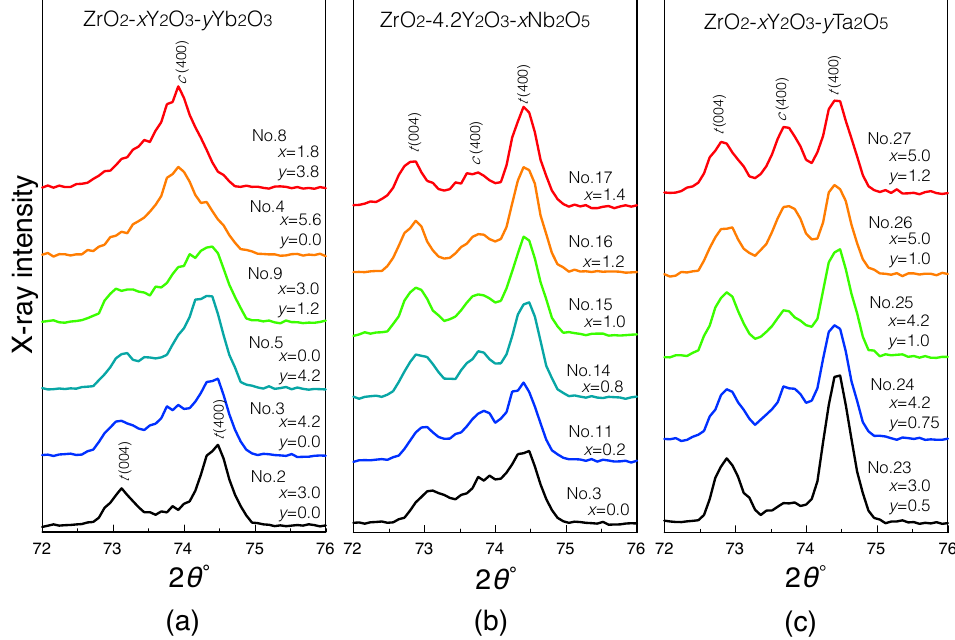
Figure 7. XRD patterns of ( a ) ZrO 2 - x Y 2 O 3 - y Yb 2 O 3 ( x = 0–5.6 and y = 0–3.8 mol%), ( b ) ZrO 2 -4.2Y 2 O 3 - x Nb 2 O 5 ( x = 0–1.4 mol%), and ( c ) ZrO 2 - x Y 2 O 3 - y Ta 2 O 5 ( x = 3.0–5.0 and y = 0.5–1.2 mol%).